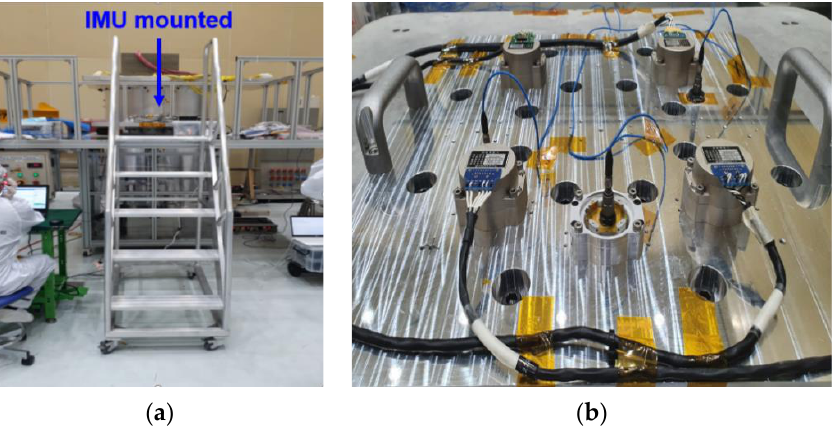
Figure 16. Simulated pyro-shock testing environment: ( a ) pyro-shock simulator; ( b ) top view of pyro-shock simulator. Table 2. Specification of pyro-shock simulator.